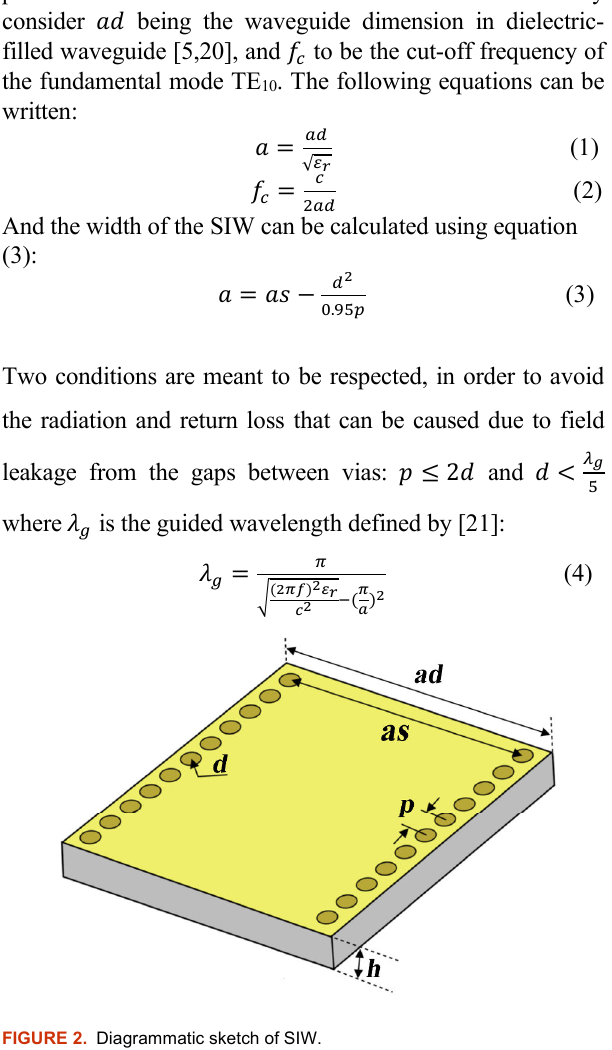
FIGURE 2. Diagrammatic sketch of